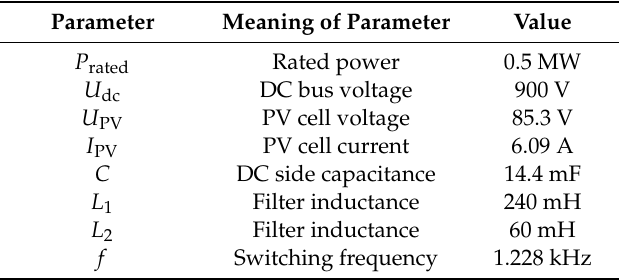
Table 4. Simulation parameters of the actual PV generation system.